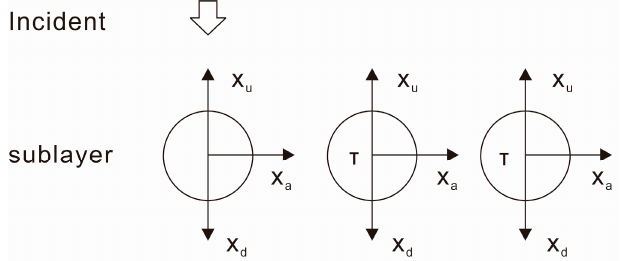
Figure 4. A schematic representation of sublayer backscattering ratio ( x ). The total outgoing radiation of the left particle is assumed to be a unit, τ is the transmittance of particles. This is in accordance with original definition which does not consider the directional change of particle scattering ratios ( x u , x a and x d